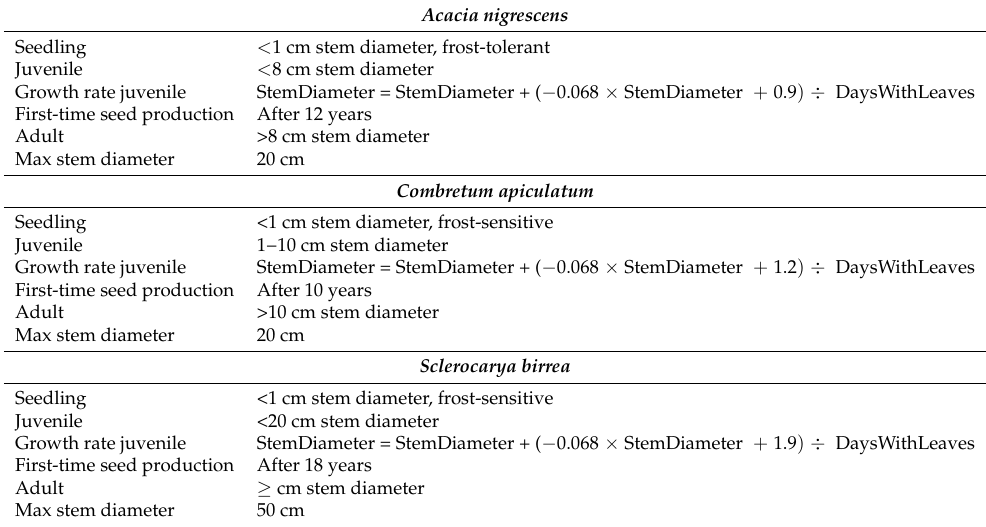
Table 1. Tree parameters per modeled